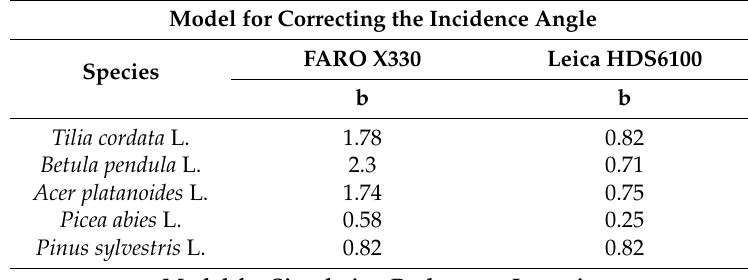
Table 3. Parameters for the models for incidence angle correction and backscatter intensity